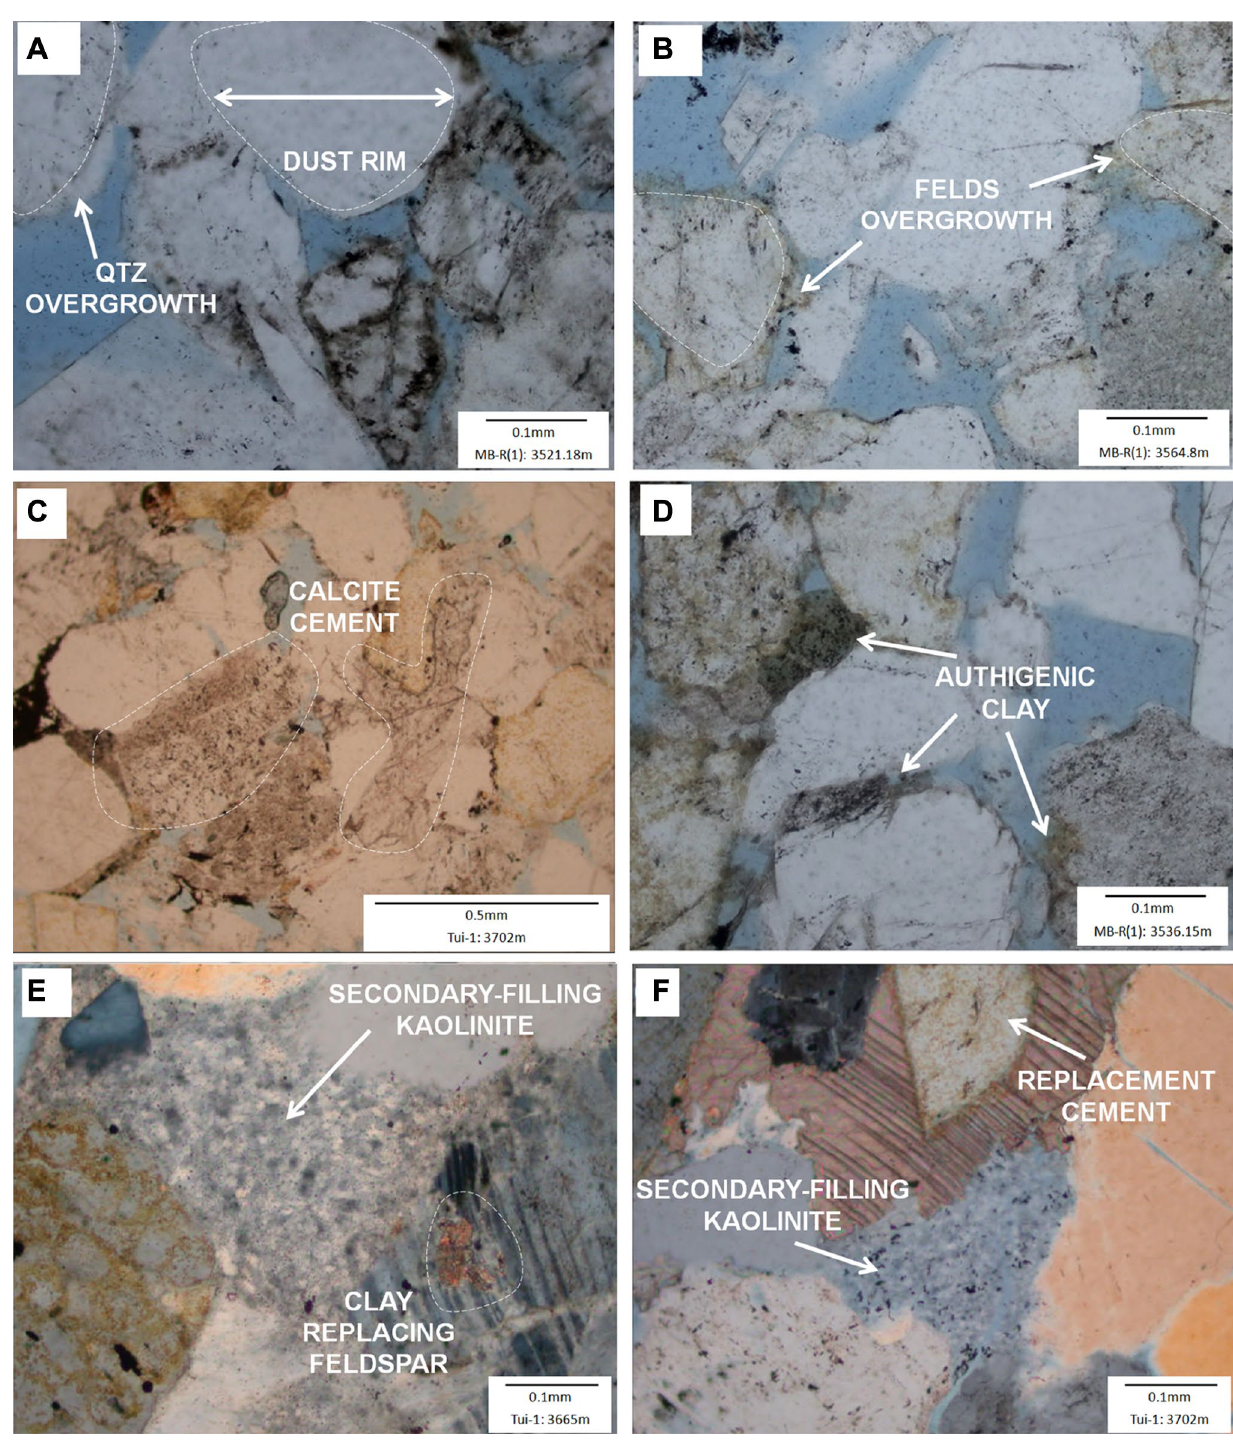
Fig. 8 Features observed in the selected Farewell Formation sample data: a quartz overgrowths with dust rims and abundant pores (inter- granular, dissolution and hybrid porosity), b feldspar overgrowths and